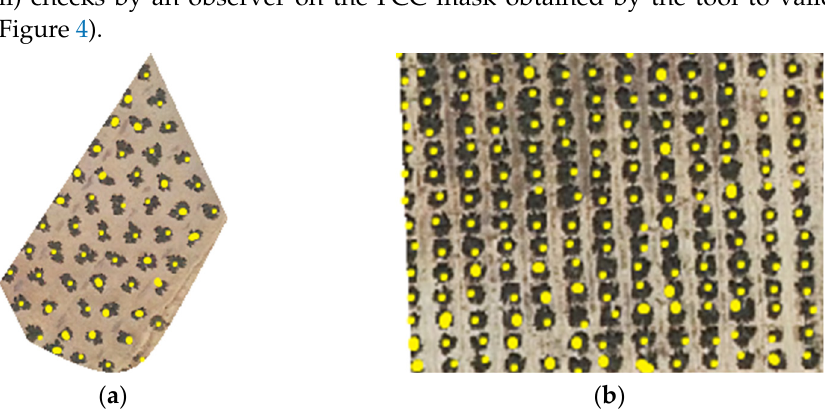
Figure 3. Example of the manual counting of olive grove plots with different plantation frameworks: ( a ) traditional olive groves; ( b ) intensive olive groves.